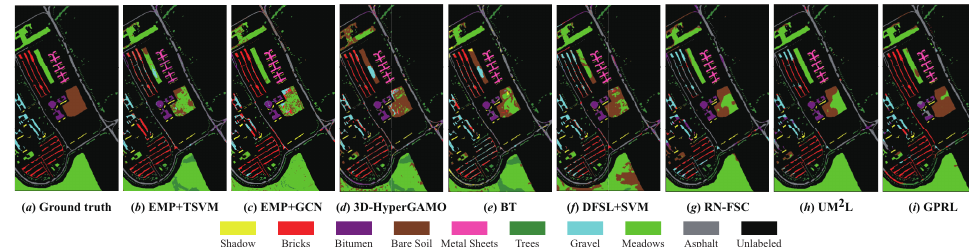
Figure 6. The classification maps of different methods on the UP data set.